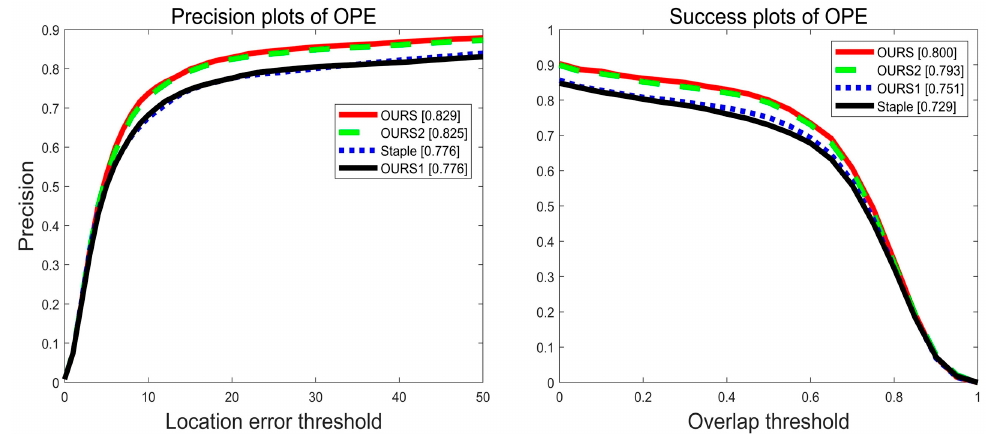
Figure 13. Precision plot and success plot of different algorithms on the OTB-2013 dataset.